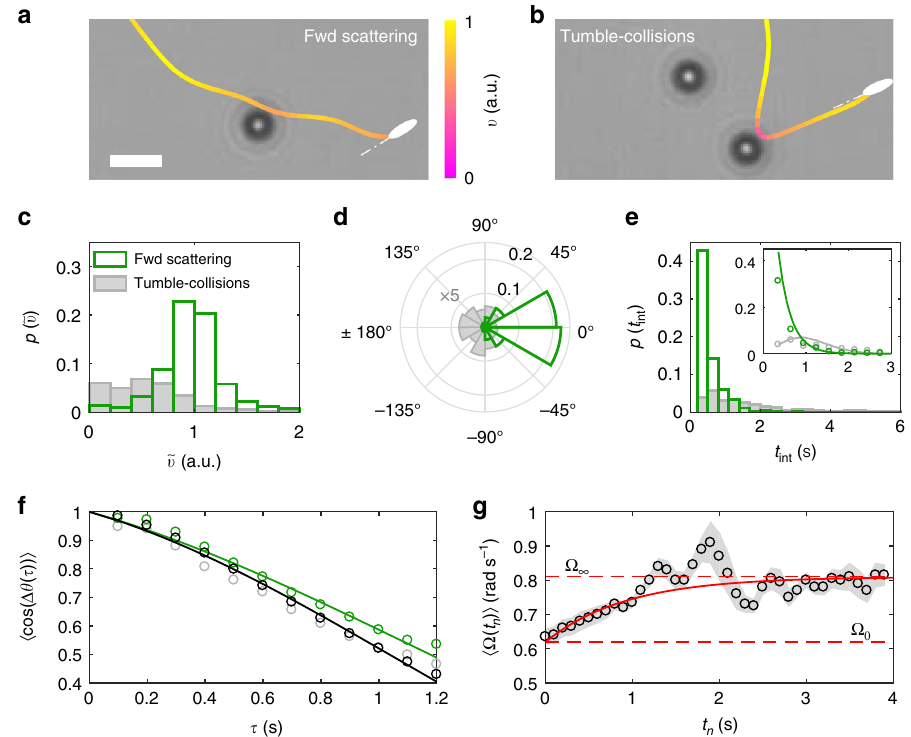
Fig. 3 Differences between cell – obstacle interactions classi fi ed as forward scattering and tumble-collisions. a , b Examples of a forward-scattering event ( a ) and a tumble-collision ( b ). The stylised cells represent the trajectories ’ fi nal position and orientation. The trajectories ’ colour code represents the cells ’ normalised instantaneous velocity v . The white scale bar corresponds to 5 μ m. c – e Probability density distributions of the cells ’ c change in relative speed ~ v , d change in direction of motion Δ θ int , and e time t int spent at the obstacles during interaction for forward scattering (empty histograms) and tumble- collisions ( fi lled histograms). All distributions are normalised to the total number of interactions to show the relative weight between forward-scattering events and tumble-collisions. In d , the distribution for tumble-collisions is 5× bigger for visualisation. In the inset in e , the experimental distributions (circles) are fi tted to an exponential distribution for forward scattering and to a Poissonian distribution for tumble-collisions (solid lines). f Average experimental decorrelation 〈 cos( Δ θ ( τ )) 〉 of the cells ’ direction of motion over time for forward scattering (green circles) and tumble-collisions (grey circles) calculated as ensemble average from the fi rst instant t 0 after at least 100 cell – obstacle interactions. For reference, the black circles show the same quantity calculated in the absence of obstacles (Eq. (3), Methods). The solid lines are fi ttings to the function f ð τ Þ ¼ cos ð Ω τ Þ e (cid:3) τ = τ 0 . g Time evolution of the cells ’ average angular speed 〈 Ω 〉 (black circles) after the end of a forward-scattering event. Each value is calculated as an ensemble average from the n -th instant t n after at least 100 forward-scattering events. The shaded area represents one standard deviation around the average values. The solid line represents the fi tting to the function f ð t n Þ ¼ Ω 1 (cid:3) ð Ω 1 (cid:3) Ω 0 Þ e (cid:3) t n = τ Ω , where Ω 0 and Ω ∞ (dashed lines) are the average angular speeds at t 0 and for ρ = 0%,